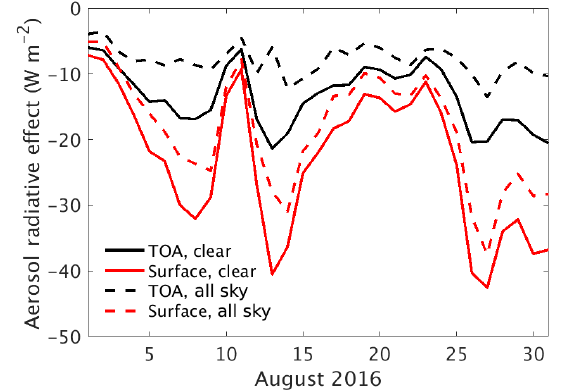
Figure 12. Direct radiative effect due to aerosols at the surface and top of the atmosphere under clear-sky and all-sky conditions during August 2016 over Ascension